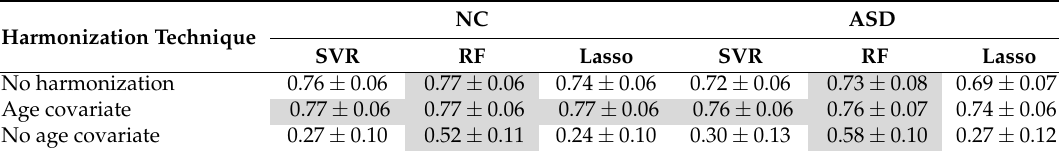
Table 3. Mean R 2 ± SD resulting from age prediction for each class and each harmonization technique for the three regression algorithms SVR, Random Forest, and Lasso. The best performances are highlighted in gray.